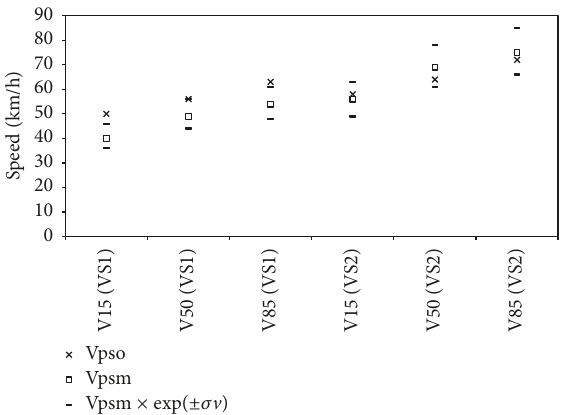
Figure 4: Validation results for conditions of low traffic volume.